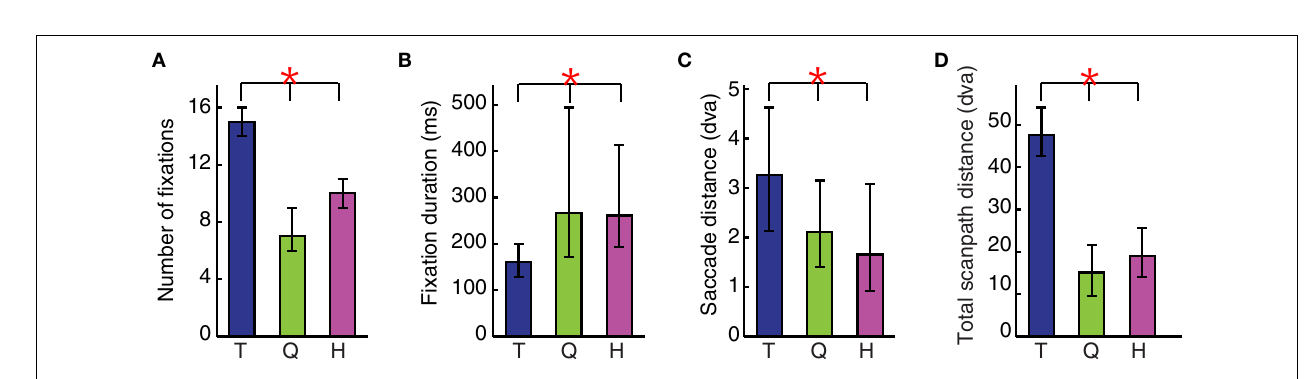
FIGURE 4 | Individual differences in four basic scanpath measures for 3 s of face scanning. (A) Average number of fi xations; (B) Average fi xation duration; (C) Average saccade distance; and (D) Total scanpath distance. Signifi cant differences were found among monkeys T (blue), Q (green), and H (magenta) on all four scanpath measures. Bars are median values, whiskers are upper and lower interquartile range. Monkey T made short but frequent